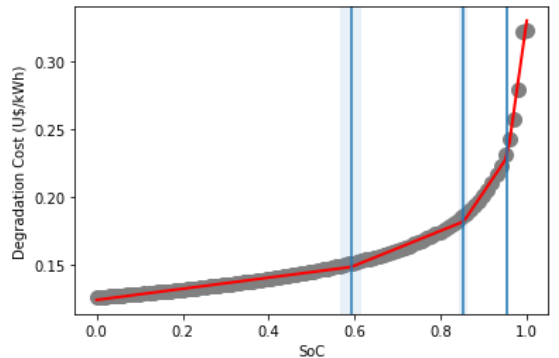
Figure 5. Piecewise linearization of battery degradation cost.